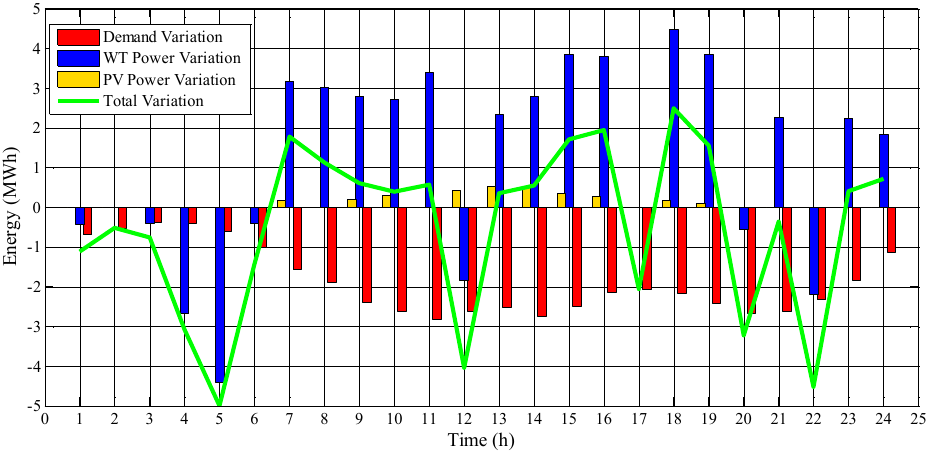
Figure 14. Changes in the DSO’s uncertain variables in scenario 6.